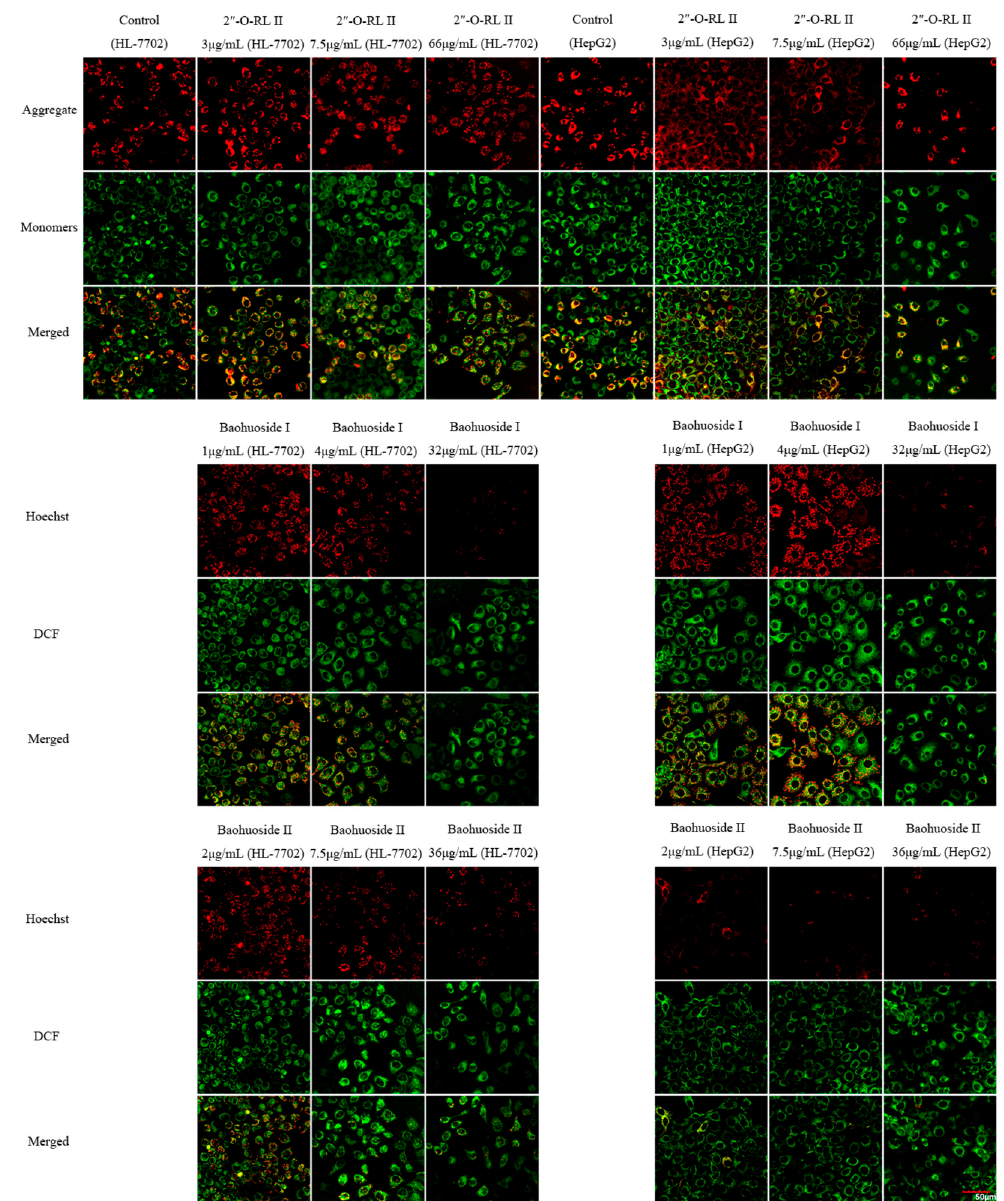
Figure 7. Effects of 2 ″ - O -rhamnosyl icariside II, baohuoside I and baohuoside II on the fluorescence intensity of JC-1 in HL-7702 and HepG2 cells. Notes: 2 ″ - O -rhamnosyl icariside II at each concentration did not cause fluorescence intensity changes. The fluorescence intensities of aggregates in the groups of baohuoside I and baohuoside II at different concentrations were weaker than that of the control group. The scale bar corresponds to 50 μ m. Magnification ×600 (2 ″ - O -RL II = 2 ″ - O -rhamnosyl icariside II).